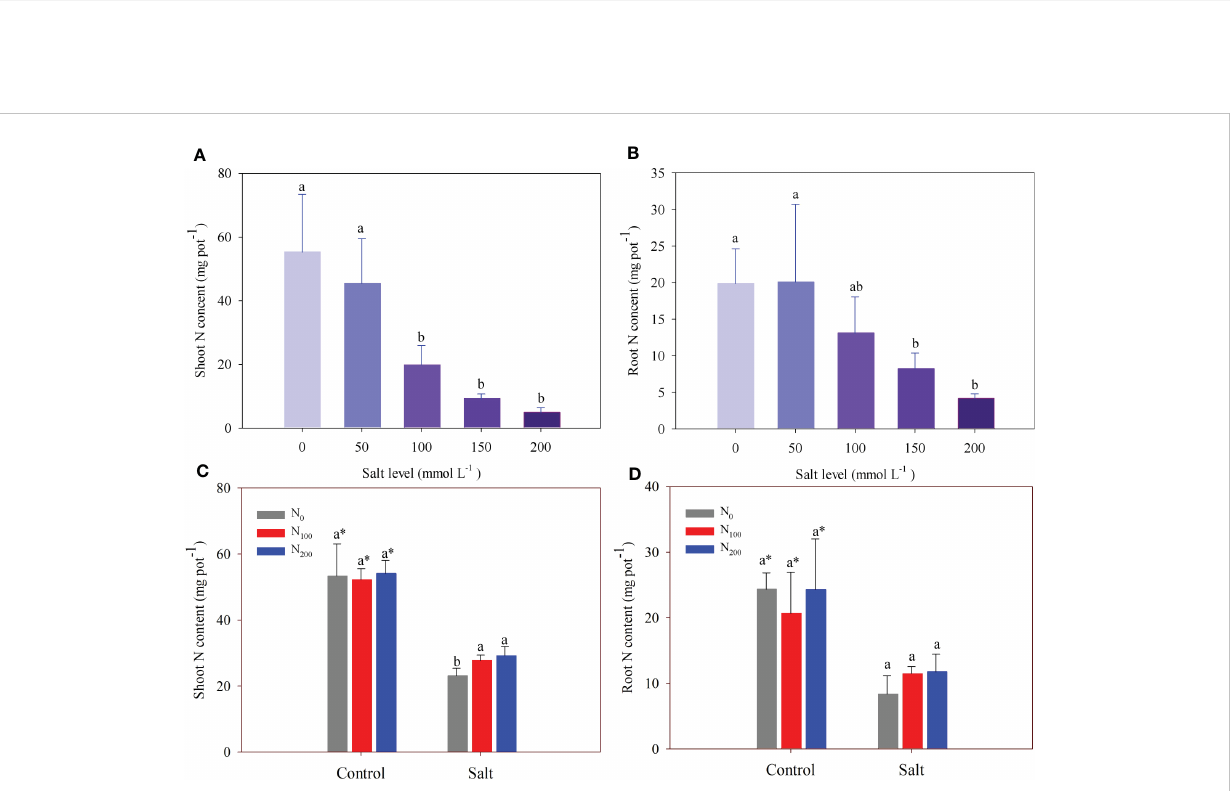
FIGURE 4 Alfalfa shoot (A) and root (B) nitrogen (N) content in different salt levels in experiment 1. Alfalfa shoot (C) and root (D) N content in different N supply and salt levels in experiment 2. Error bars represent ± SD of the mean. Different letters represent a signi fi cant difference among treatments ( p ≤ 0.05). Asterisks refer to signi fi cant differences between salt levels at the same N fertilizer supply rates.